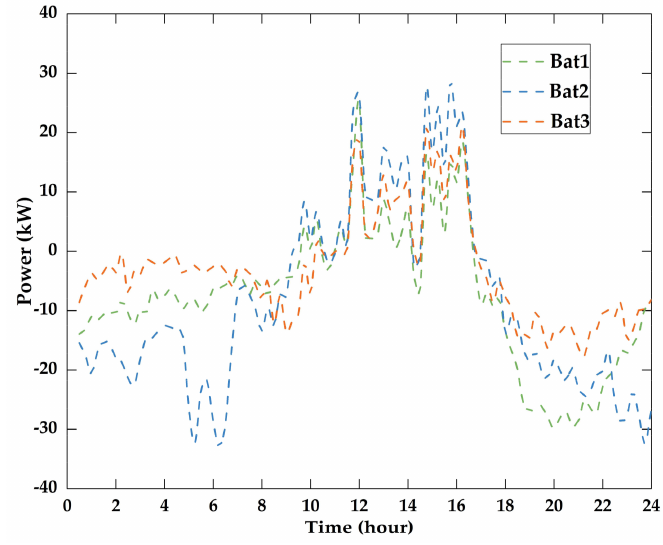
Figure 15. Battery power when modules run